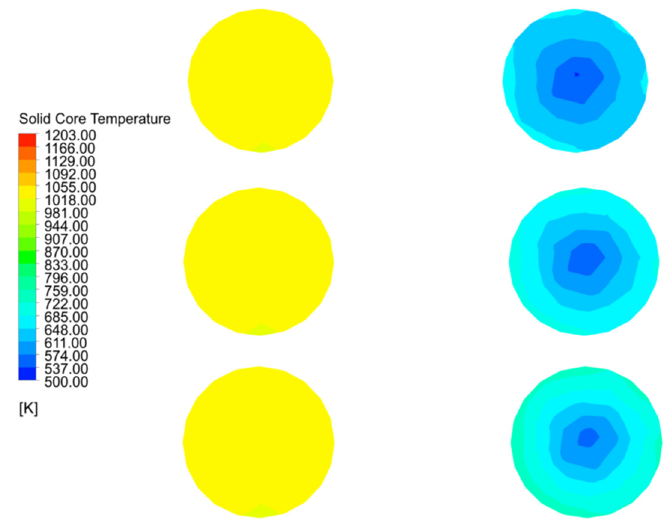
Figure 18. Solid core temperature distribution on double chambers and solid core temperature variation in chamber 2 on Plane 3.